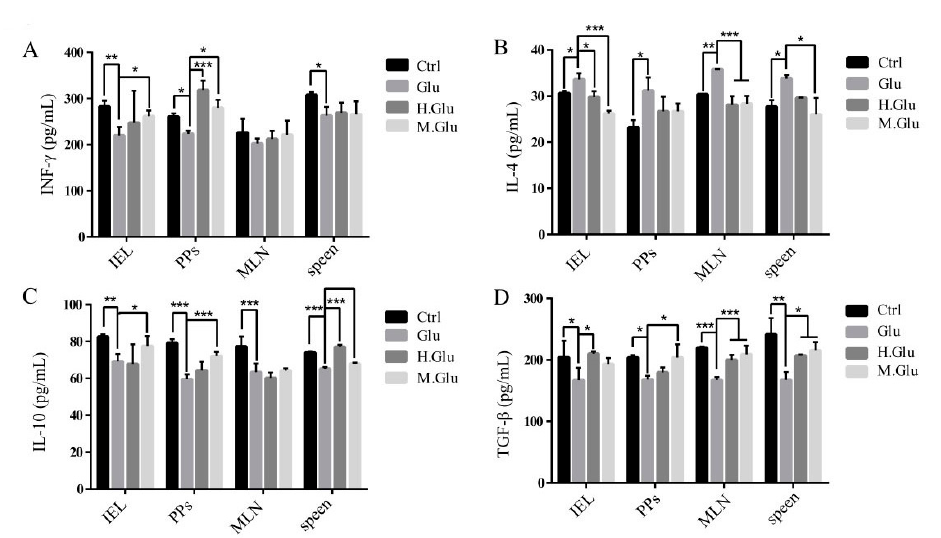
Figure 4. MGO-glutenin regulated mouse immune response by inducing Treg differentiation. The production of IFN- γ ( A ), IL-4 ( B ), IL-10 ( C ), and TGF- β ( D ) cytokines measured by ELISA in the supernatant from lymphoid cells. Ctrl represents the control group and Glu, H.Glu, and M.Glu represent native glutenin, heated glutenin, and MGO-glutenin, respectively. Significant differences of Glu versus H.Glu and M.Glu group are indicated as * p < 0.05, ** p < 0.01, *** p < 0.001.